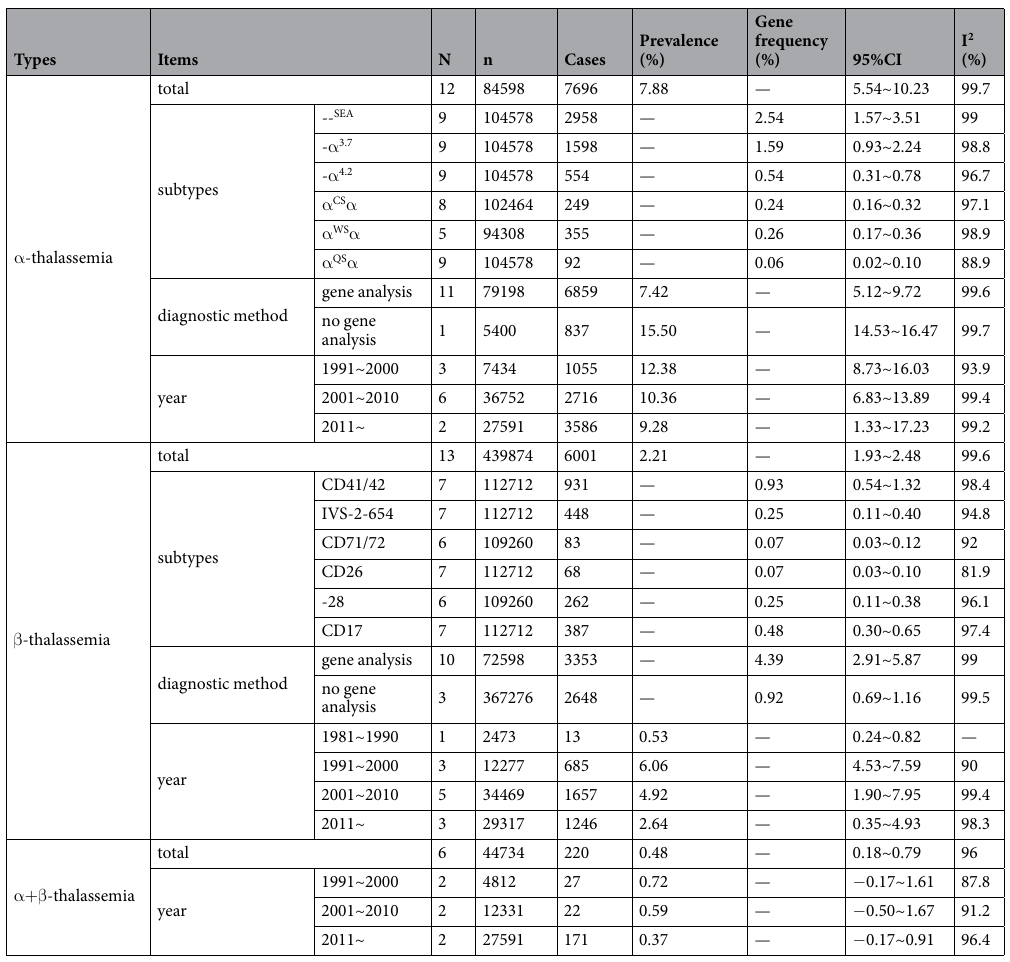
Table 2. Summary of the prevalence estimation for